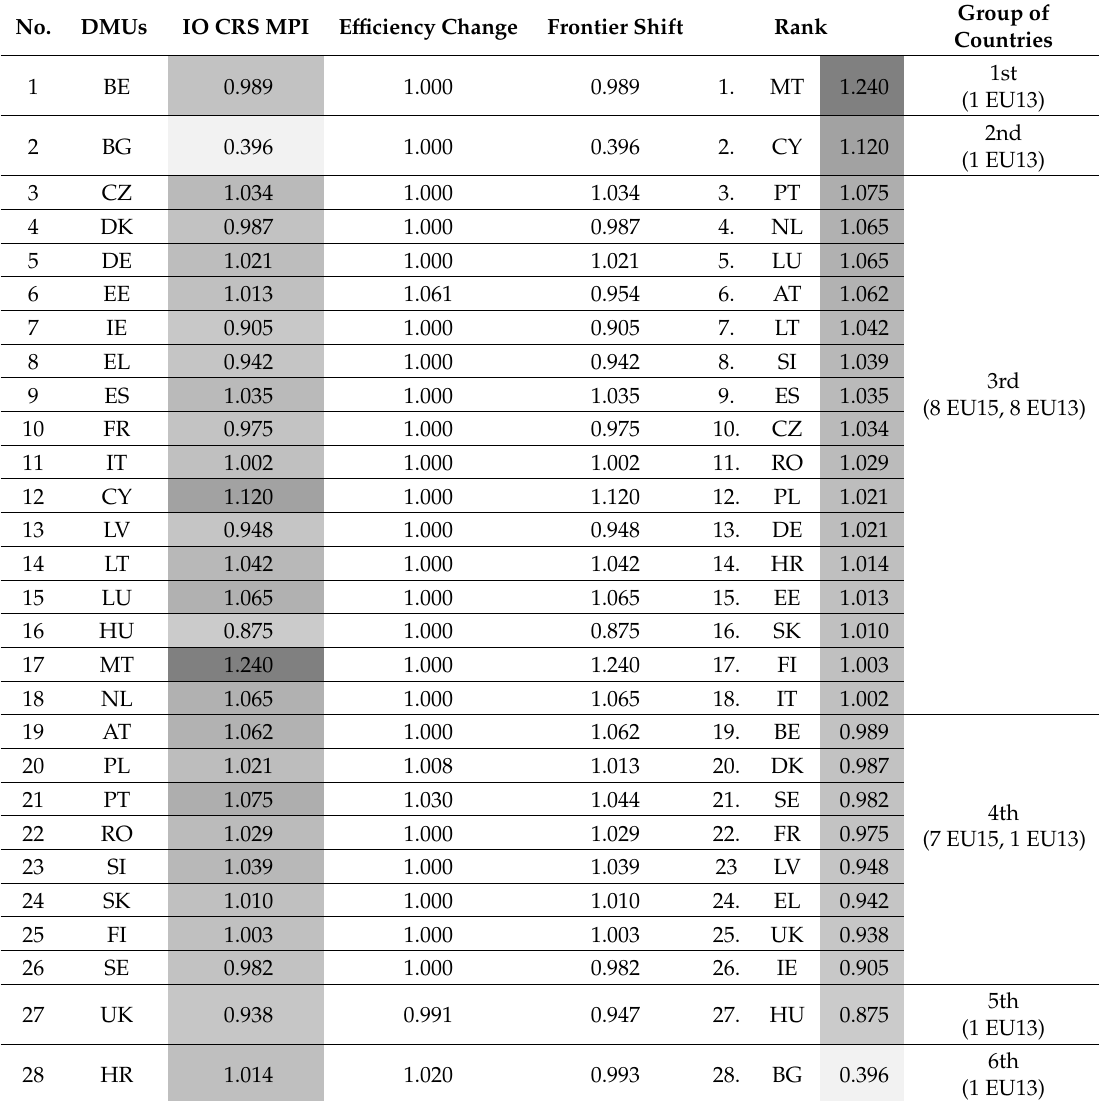
Table 9. MPI results for period 2008–2011 (source: own calculation and